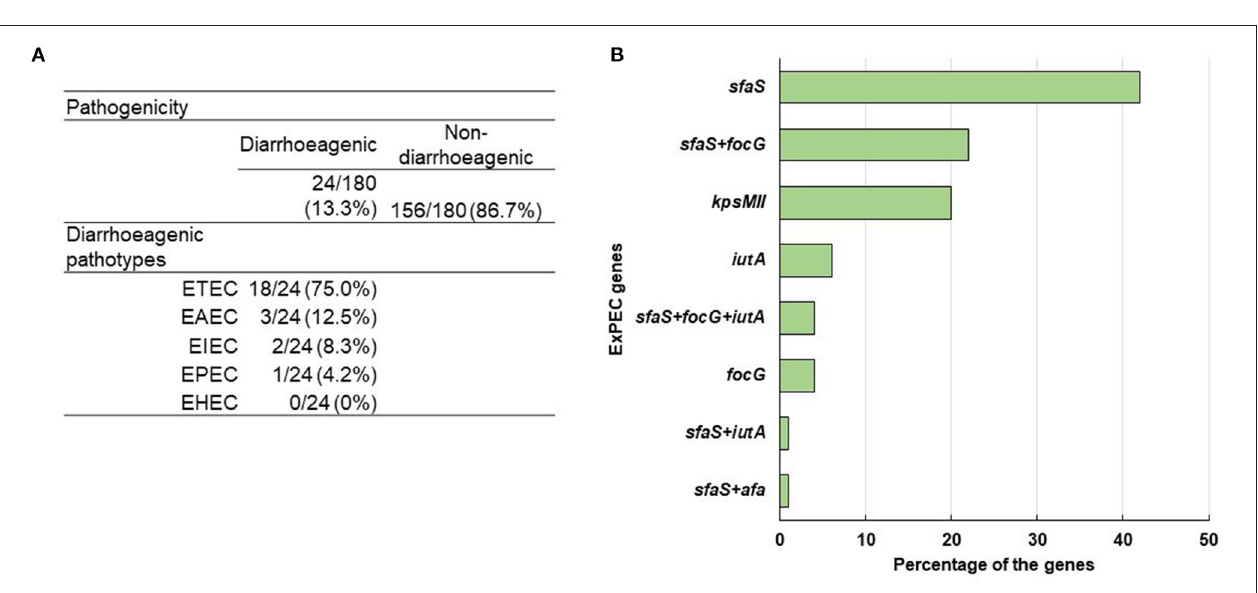
44% (12/27) to nalidixic acid, 26% (7/27) to ciprofloxacin, 26% (7/27) to sulfamethoxazole-trimethoprim, 7% (2/27)